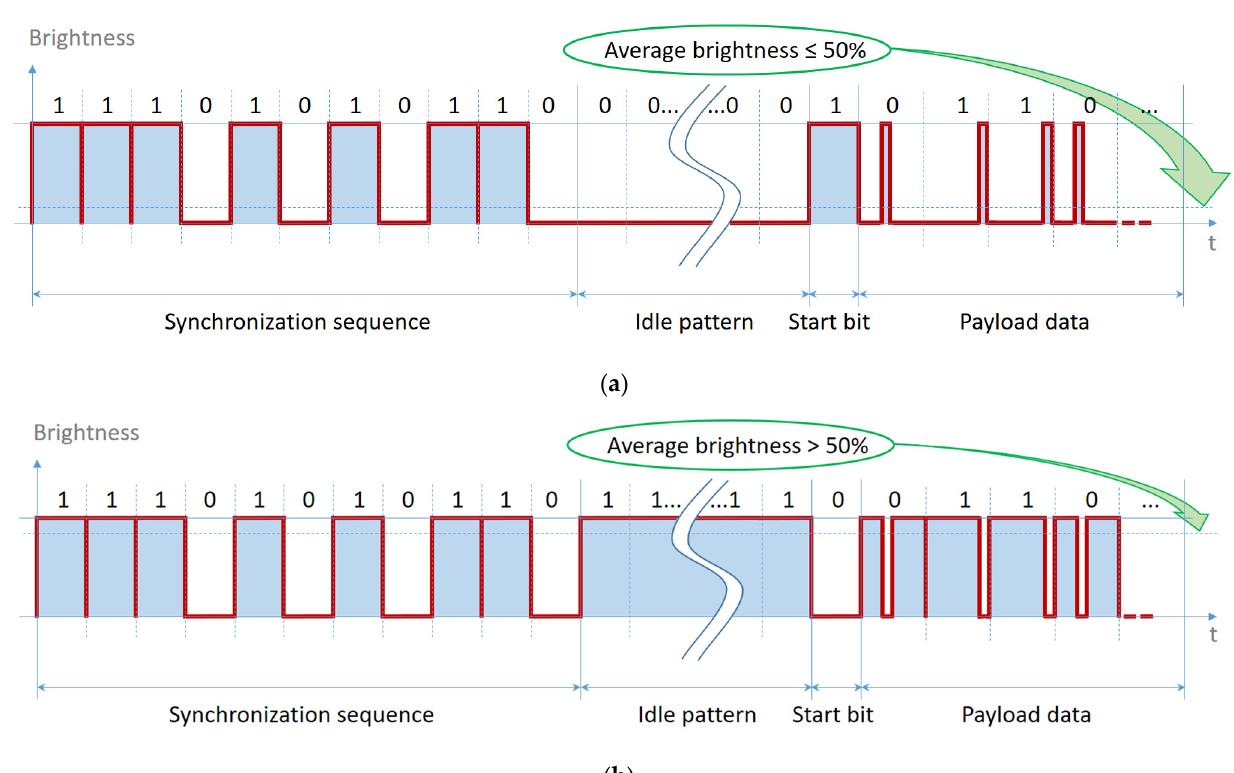
Figure 8. The structure of the proposed data frame: ( a ) Average brightness less than or equal to 50%; ( b ) Average brightness greater than 50%.